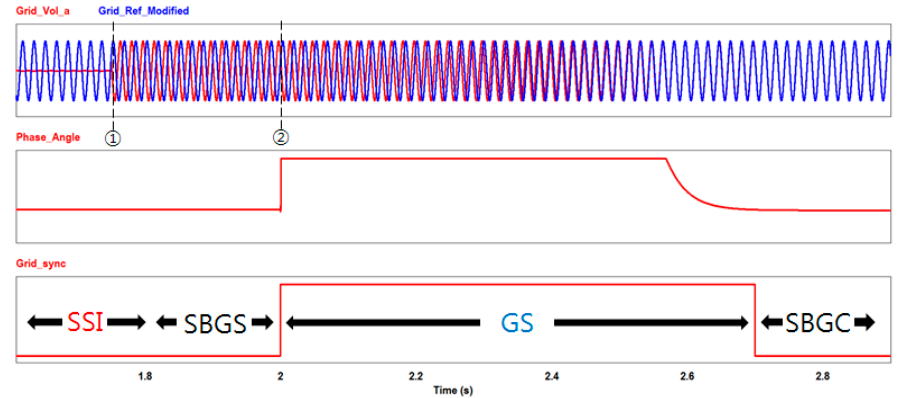
Figure 8. Ideal waveforms of grid synchronization mode (Top: Measured grid voltage and modified grid voltage. Mid: Phase angle during islanded mode. Bottom: GS status signal. ① Grid has been restored, and ② grid synchronization mode starts).